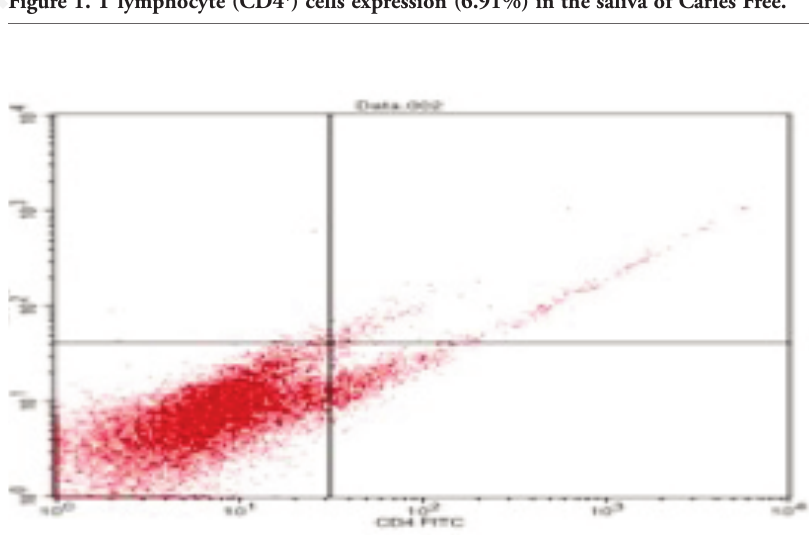
Figure 2. T lymphocytes (CD4 + ) cells expression (5.60%) in the saliva of